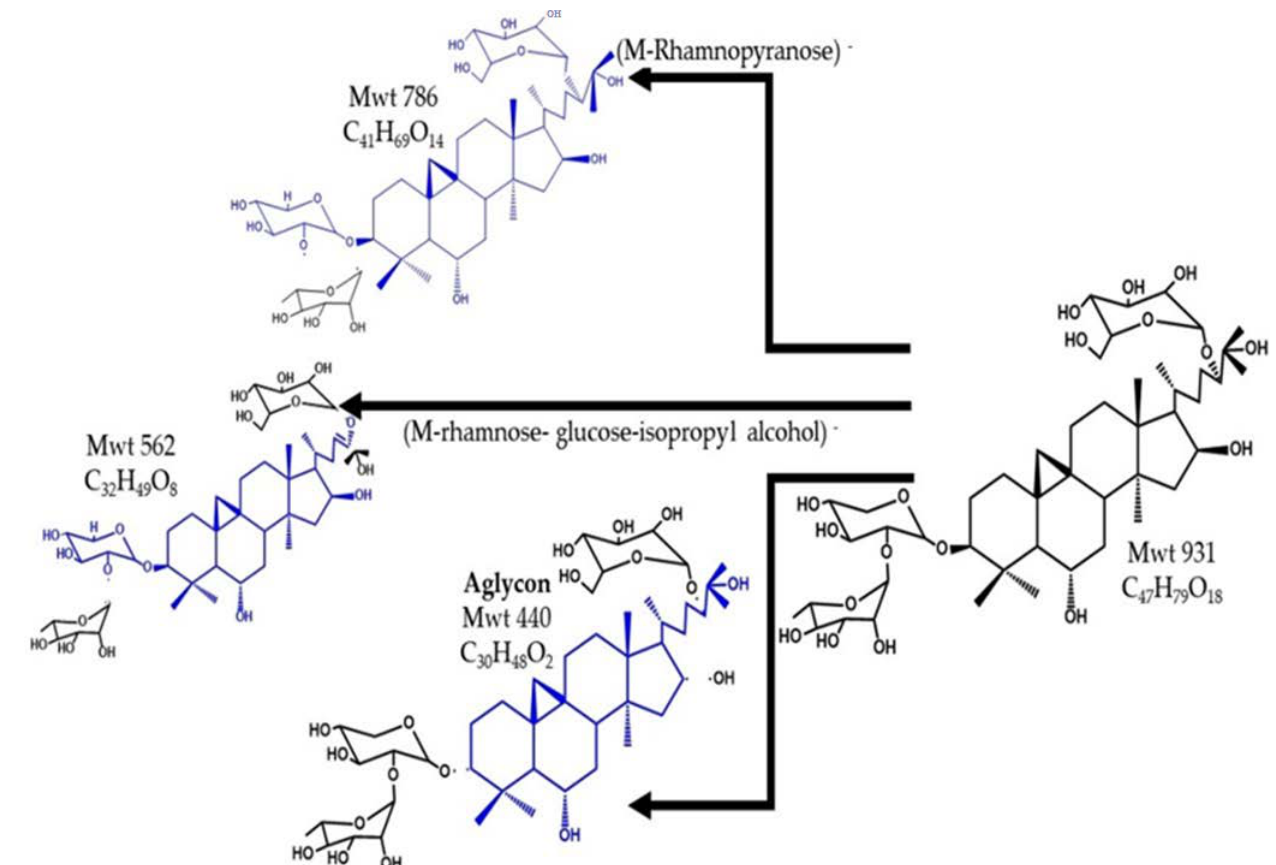
Figure 6. The structure and fragments of trojanoside